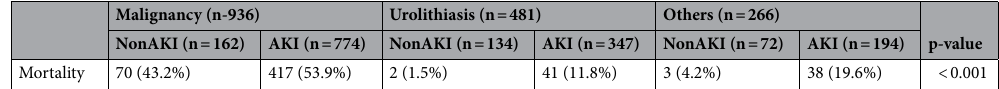
Table 6. Mortality of obstructive uropathy. AKI acute kidney